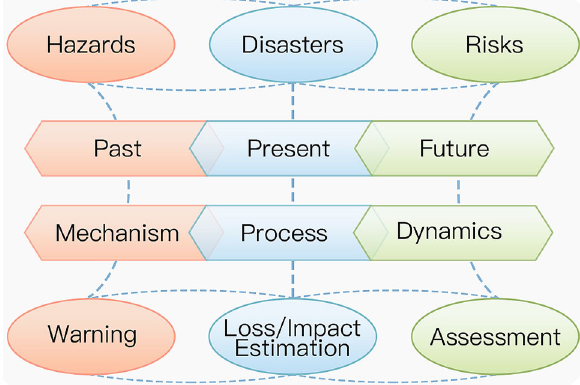
Fig. 1 Relationships between hazards, disasters, and